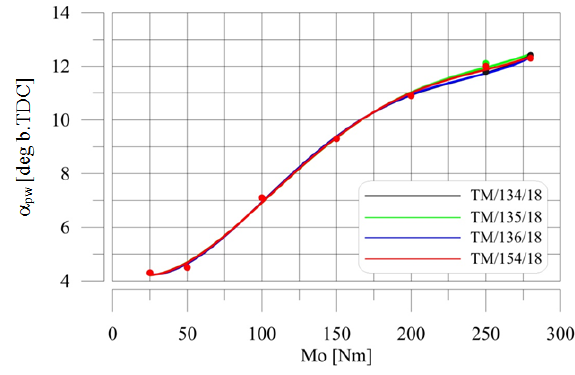
Fig. 1. Impact of the engine load on the start of fuel injection (  pw ) for the 4 tested fuels Of course, as the engine load increases, the optimum fuel injection start is earlier, which is ensured by the engine controller, in the same way for all the